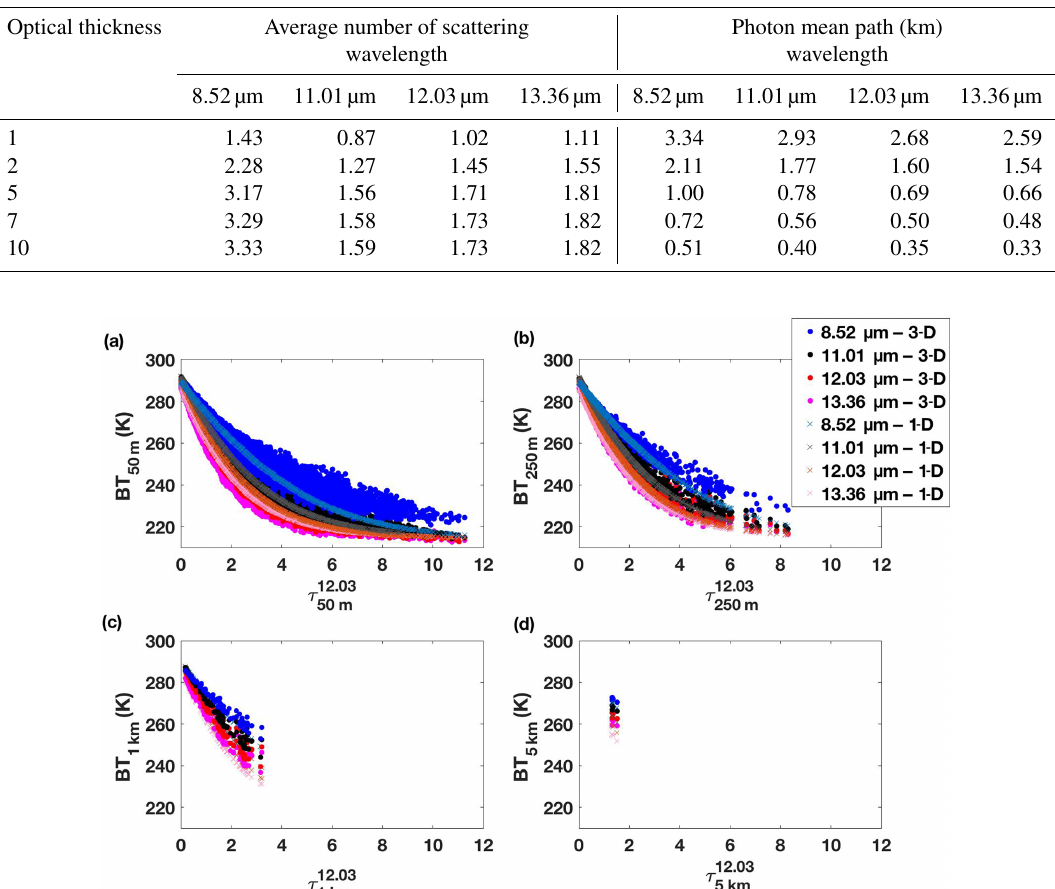
Table 3. Average number of scattering and photon mean horizontal displacements (photon mean path) as a function of the optical thickness for channels centered at 8.52, 11.01, 12.03 and 13.36µm.